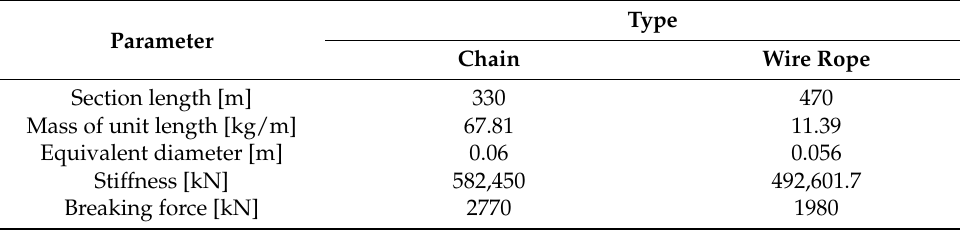
Table 3. Main parameters of the mooring lines of the vessel.